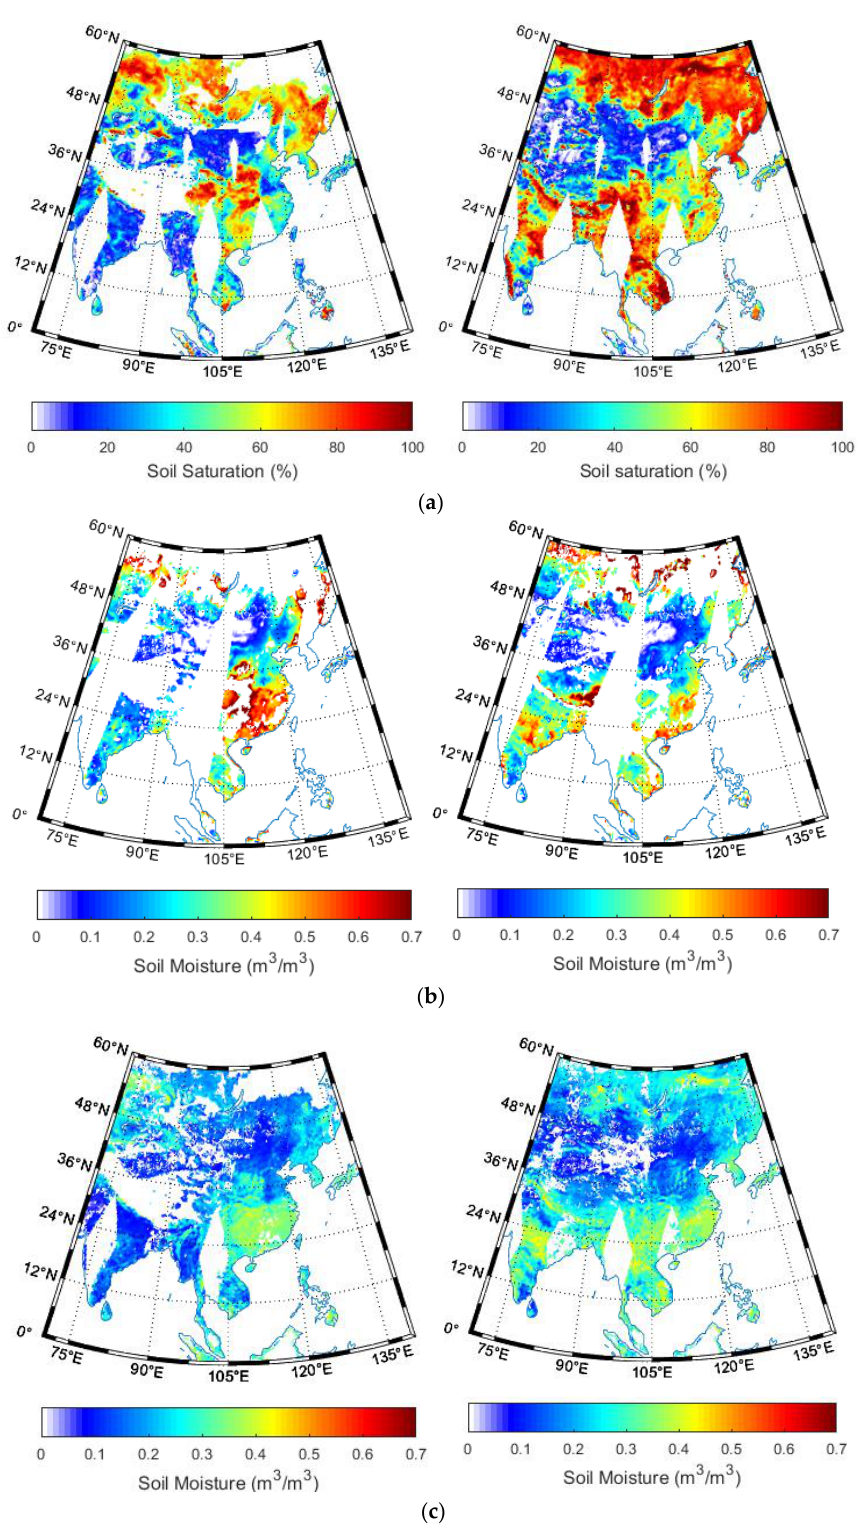
Figure 4. Extracted soil moisture retrieved from ( a ) active ( b ) passive ( c ) combined microwave signals over China on 15 April (left) and 27 July (right) 2014.